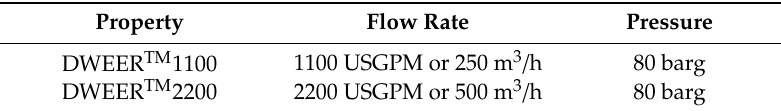
Table 1. DWEER TM sizes.